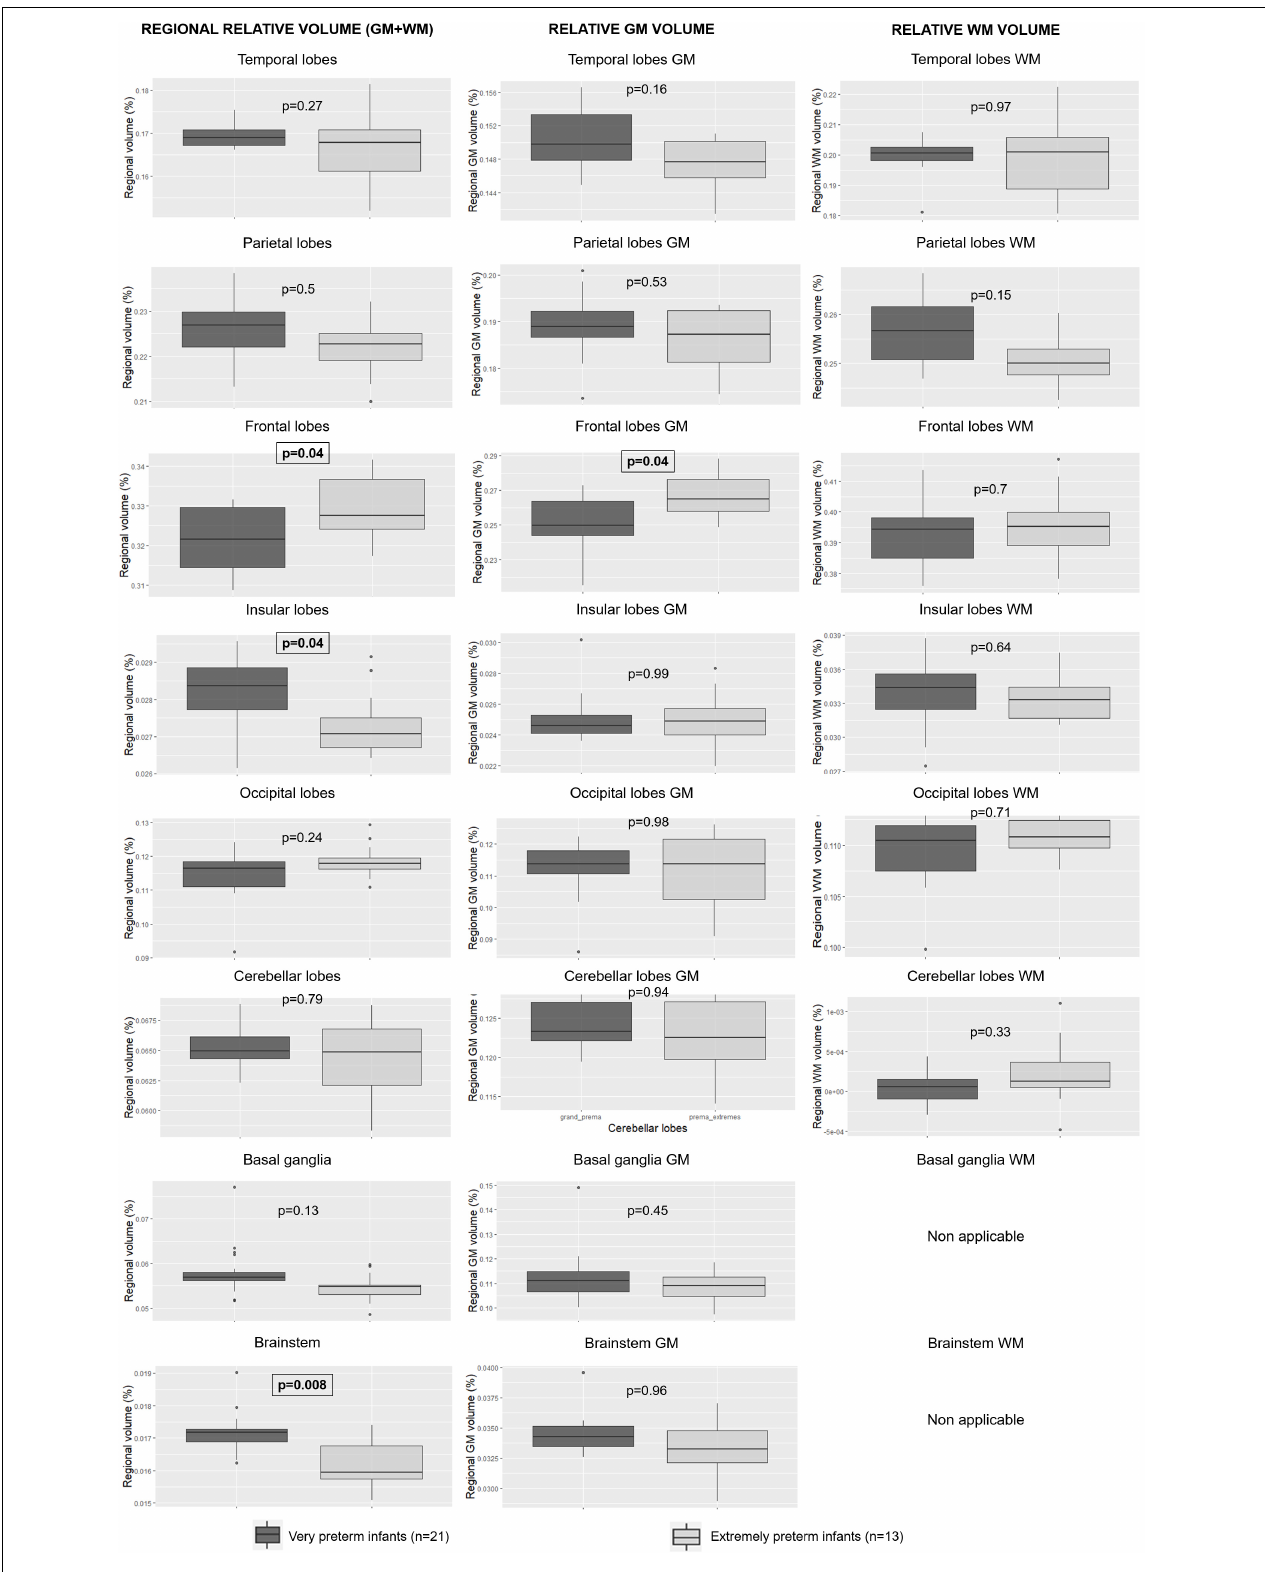
FIGURE 4 | Relative regional, GM and WM volumes according to degree of prematurity. GM: gray matter; WM: white matter. The significant p -values are in bold characters within a square frame.